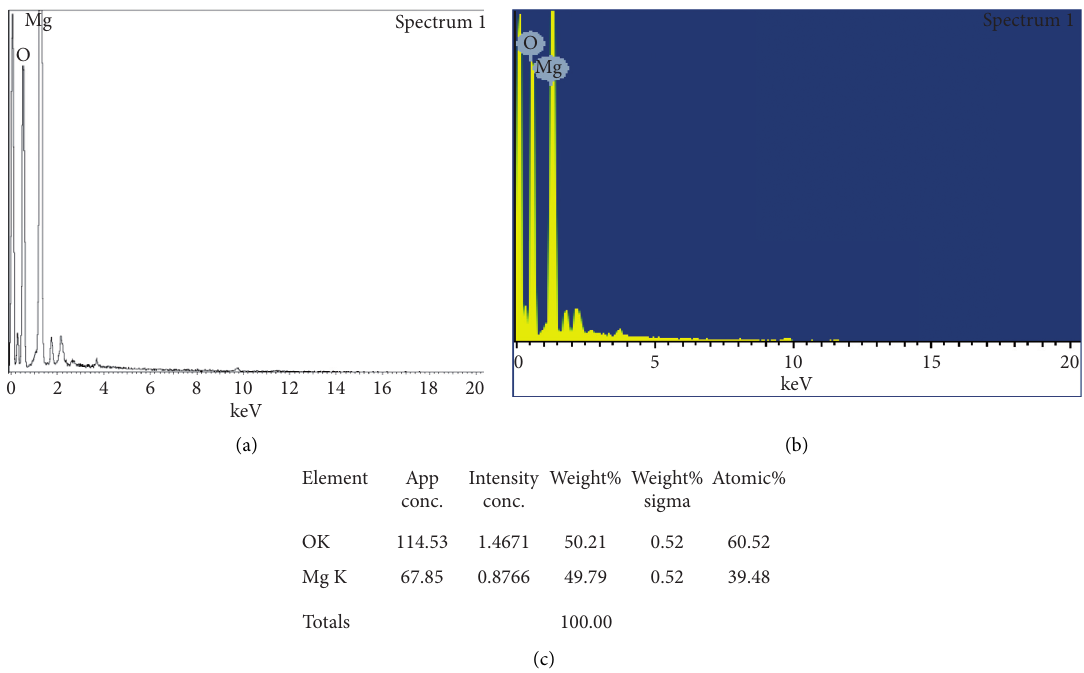
Figure 8: Energy dispersive X-ray spectroscopy (EDX) spectra of MgO nanoparticle (a, b) and atomic percentage of Mg and O (c).